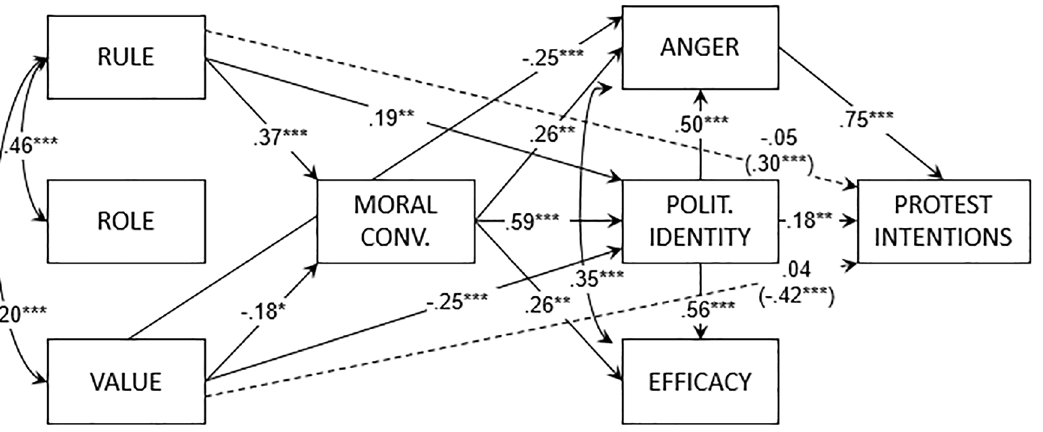
Figure 2. Path model of Study 2 (law-enforcing protest group). Note . Reported coefficients are standardized. In parentheses, the indirect effects from the orientations to protest intentions. Polit. = Politicized.